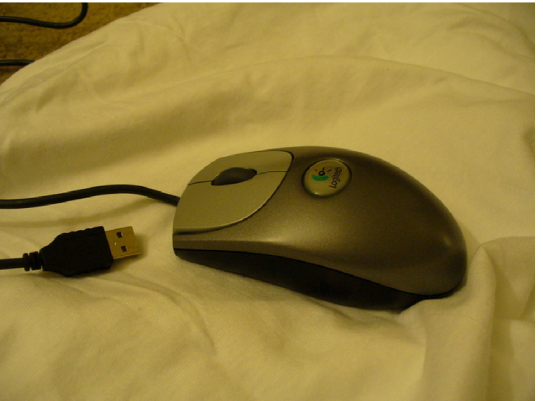
Figure 8. Logitech IFeel Mouse